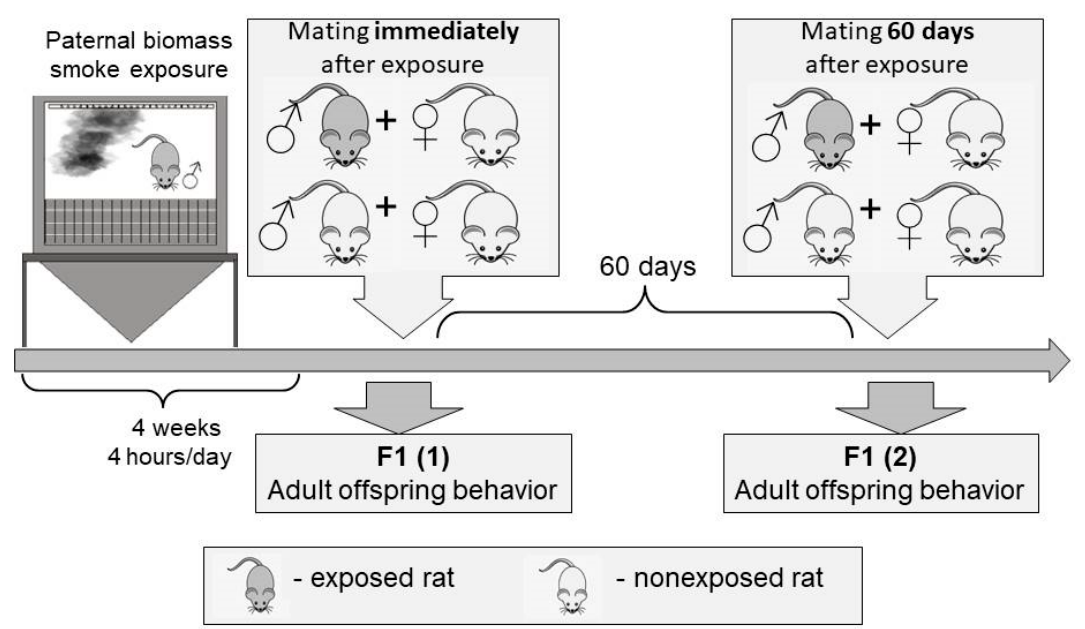
Figure 1. Design of the experimental study. Experimental design: Male rats were exposed to biomass smoke (4 hours/day, 5 days/week, for 4 weeks). Exposed or control males were mated with unexposed female rats, to generate the offspring: immediately after exposure and after 60 days (long-term period). Behavior and cognitive abilities of offspring born by mating immediately after exposure (F1 (1)) and offspring born by mating in the long-term period after exposure (F1 (2)) were assessed.